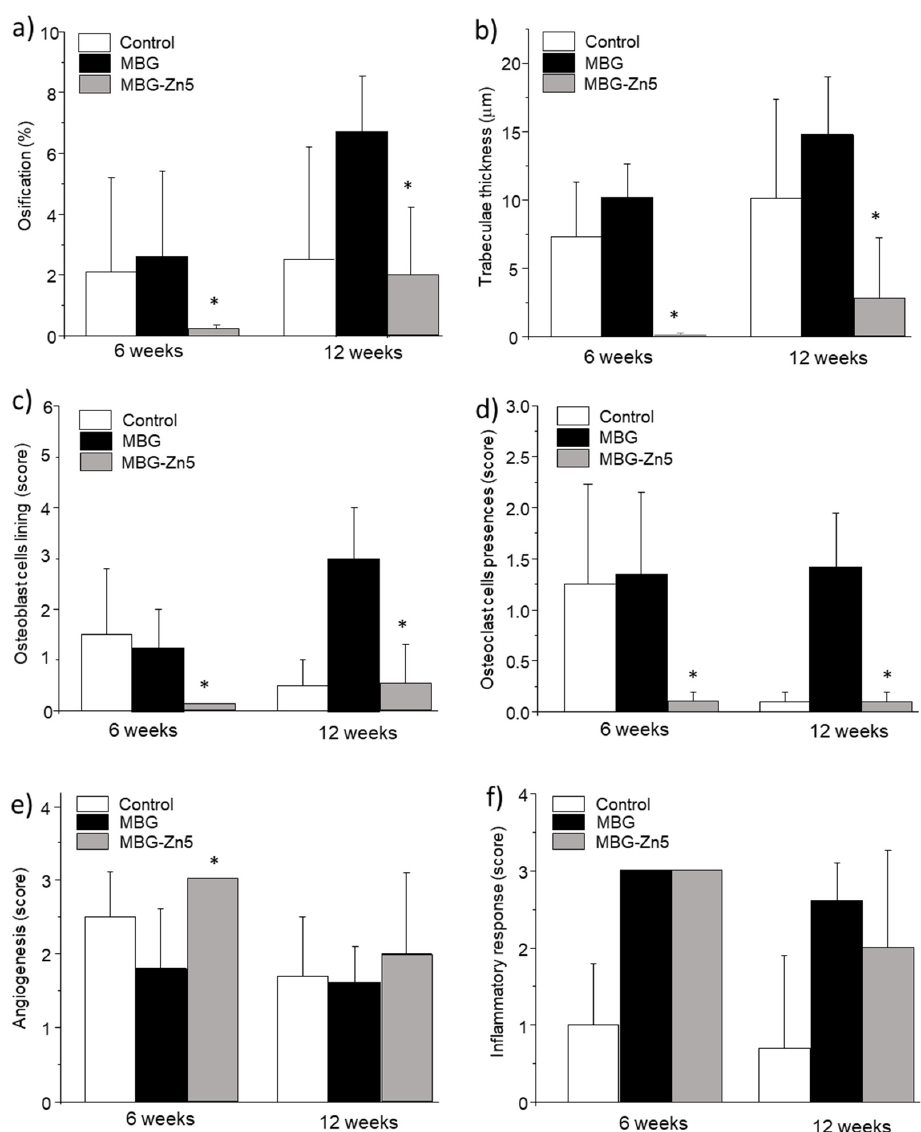
Figure 11. Histomorphometrical studies for the different materials implanted. ( a ) Ossification volume, ( b ) trabeculae thickness, ( c ) Osteoblast cells lining, ( d ) Osteoclast cells presence, ( e ) Angiogenesis, and ( f ) Inflammatory component. * Comparison between MBG (blank) and MBG-Zn5. Statistical significance: * p < 0.05.